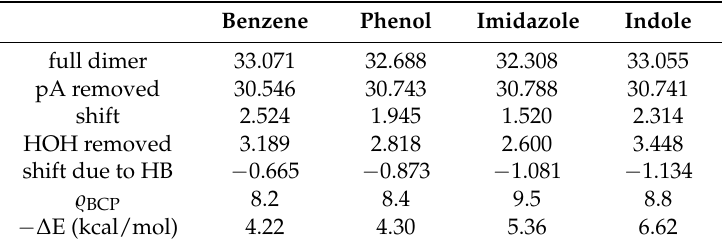
Table 4. NMR isotropic shielding (ppm) of OH ·· π complexes shown in Figure 5, along with density